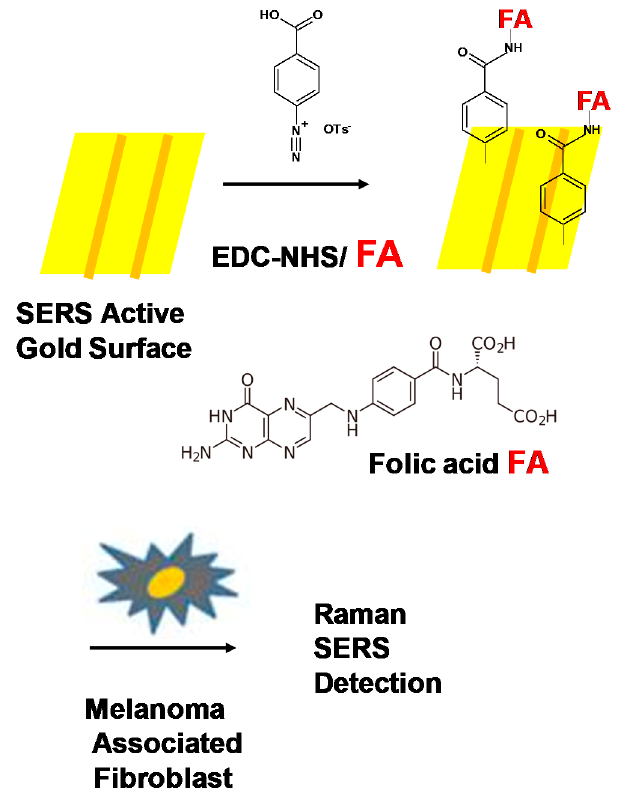
Figure 22. Detection of normal and melanoma-associated cell secretome by SERS (surface-enhanced Raman spectroscopy).